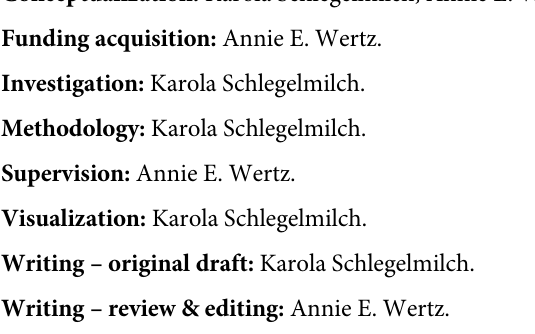
Table: Number of trials per factor level, in the original experiment and in the infant and adult